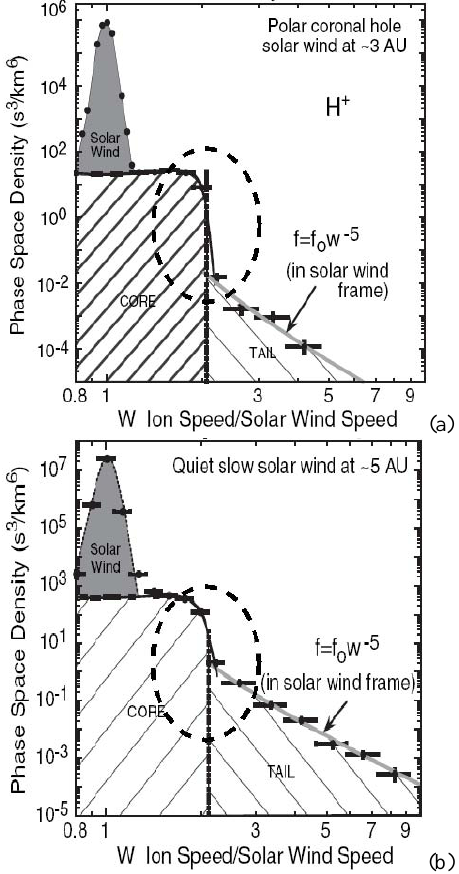
Fig. 1. The observed suprathermal ion tails in the fast (a) and slow (b) solar wind. Three populations are distinguished, namely the thermal solar wind as well as the suprathermal core and tail ions. The dashed lines encircle the step feature (adopted from Fisk and Gloeckler,